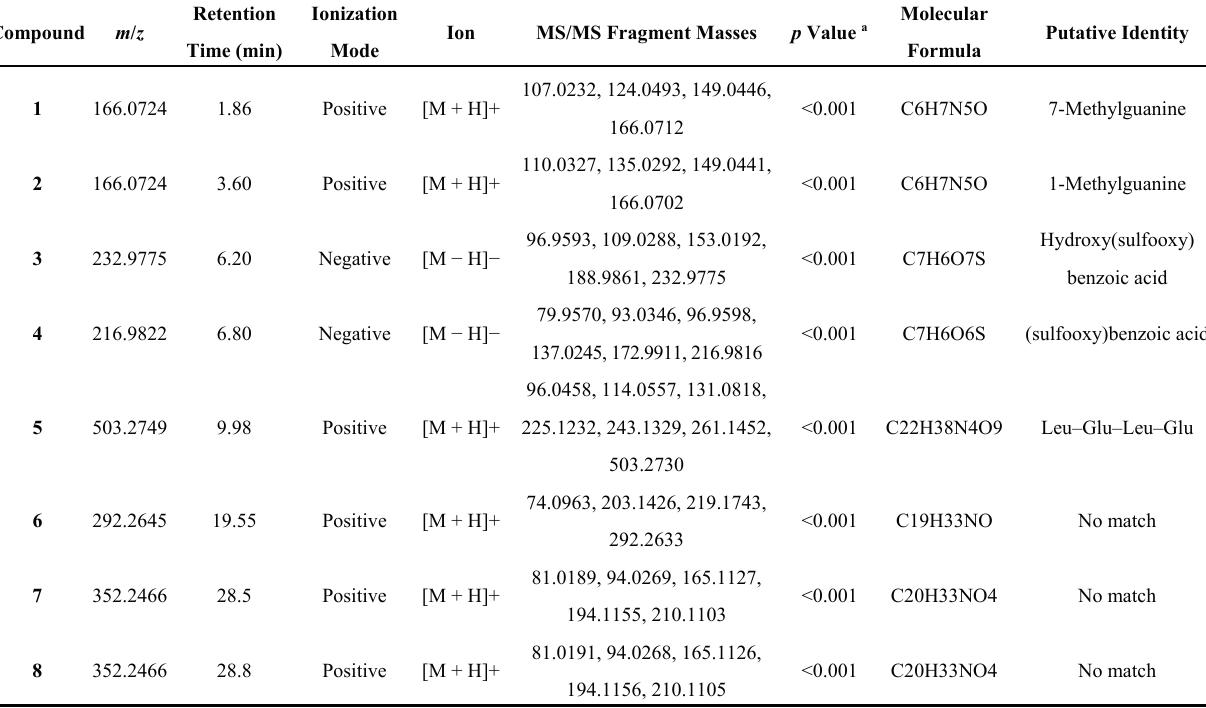
Table 1. Specific metabolites in culture supernatant of Aspergillus